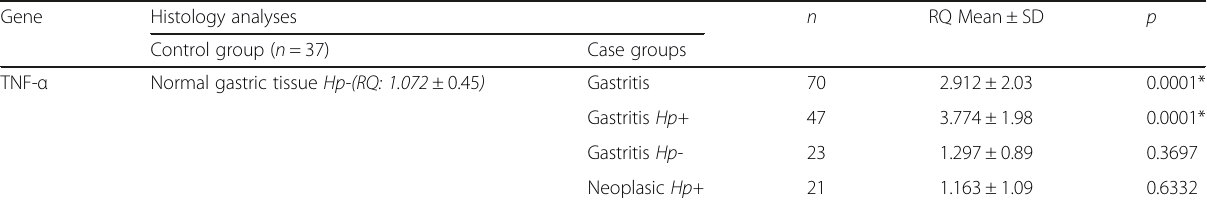
Table 3 Comparing the mRNA expression between control and case groups Gene Histology